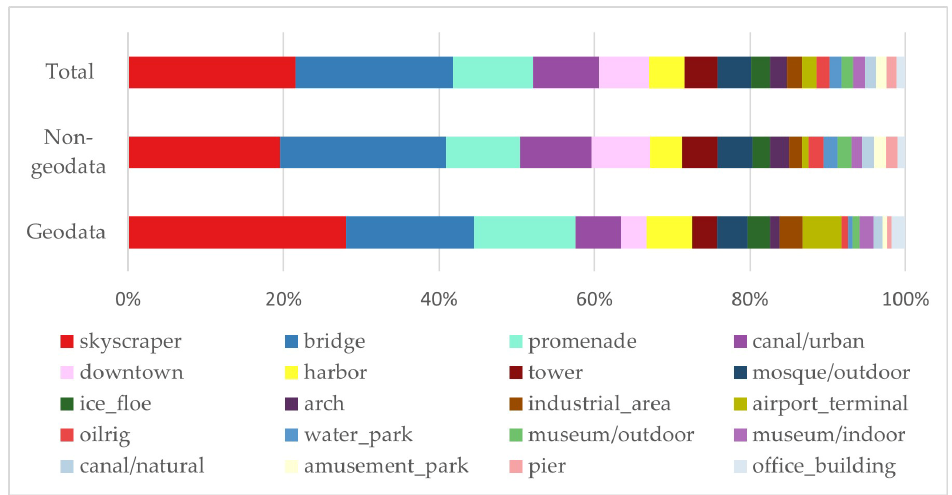
Figure 13. The proportion of Top 20 image classification results for geodata and non-geodata images.